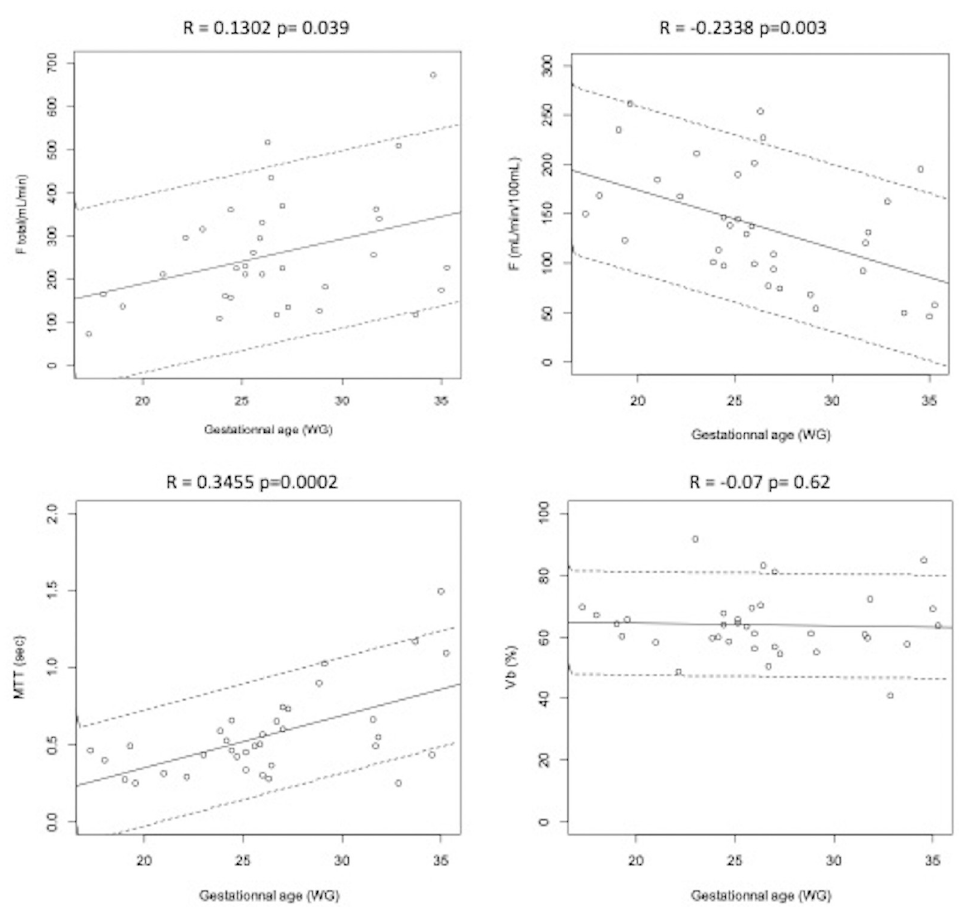
Fig 6. DCE MRI parameters as a function of the term of pregnancy in weeks gestational age (WG) among appropriate for gestational age fetuses AGA (n = 35). DCE perfusion parameters were presented: Ftotal: Total placental blood flow, in mL/min; F: Placental blood flow, in mL/min/100mL; MTT: Mean Transit Time, in seconds; Vb: Blood volume fraction of the maternal vascular placental compartment, in %. The solid line represents regression model and dotted line represents 5 th and 95 th confidence